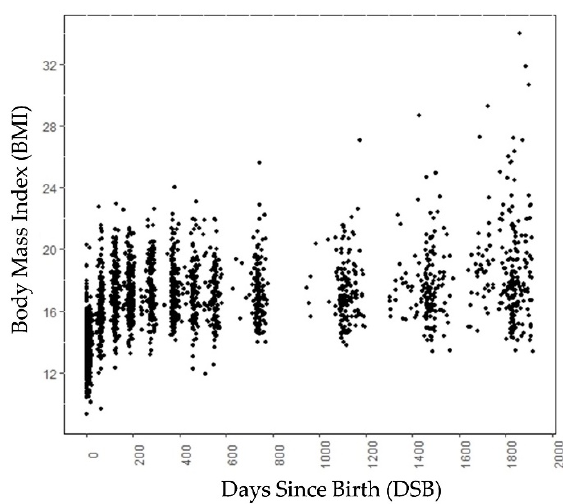
Figure 1. Scatter plot of data samples (BMI) of children at different DSB. Note that the data points are not at exact intervals, i.e., each subject has data points for different DSB.